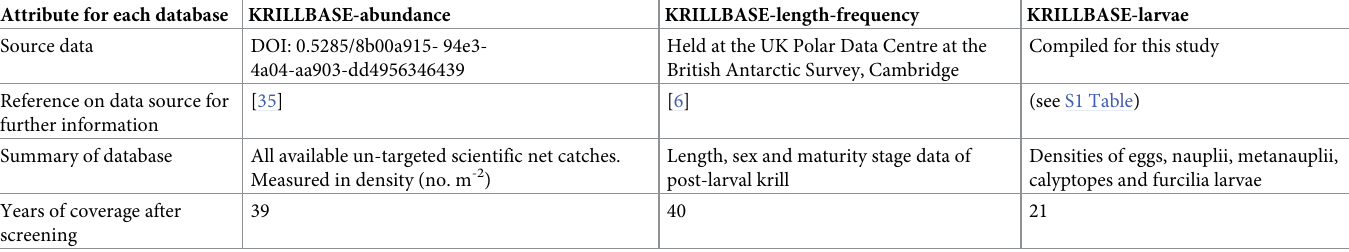
Table 1. Summary of the three composite databases that were used for this study. Attribute for each database